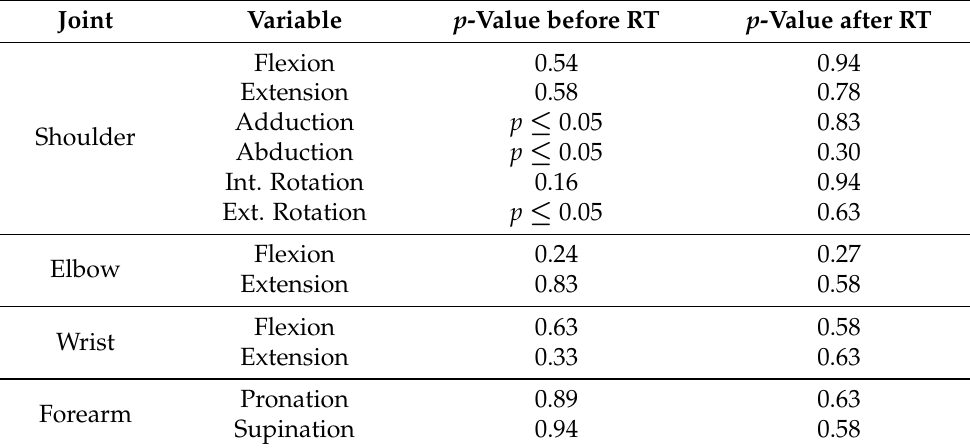
Table 10. Maximum angles Wilcoxon test of the paretic and non-paretic limb in the Apley Scratching Test before and after the rehabilitation